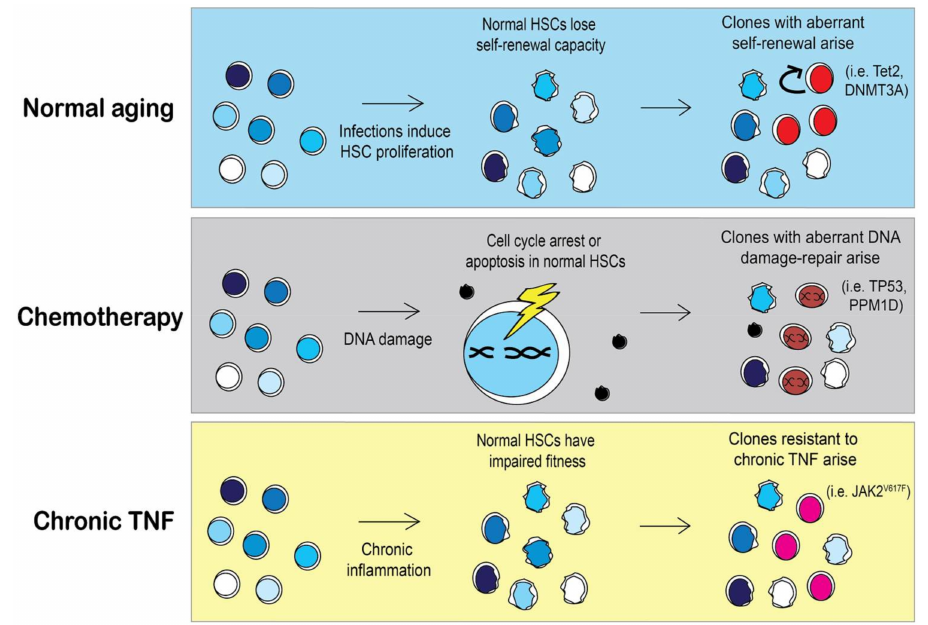
Figure 4. Selective pressures may shape clonal expansion of mutant HSCs. During aging HSCs lose their self-renewal capacity as the cells continuously replenish the blood system. As a result, HSCs with mutations that skew towards self-renewal, such as Tet2 or DNMT3A, will have a selective advantage over aged HSCs [84,86]. However, in a person that previously received chemotherapy, HSC clones with different mutations will arise. Chemotherapy induces DNA damage in HSCs and activates DNA damage repair pathways or apoptosis. The incidence of HSCs with mutations in DNA damage repair pathways such as TP53 or PPM1D is significantly higher in people with previous chemotherapy treatment [66]. Specific pressures may allow for the expansion of less common mutations such as JAK2 V617F . MPN patients with JAK2 V617F mutations have elevated TNF α , contributing to the chronic inflammatory environment. Under chronic inflammation, normal HSCs will become exhausted and lose their competitive fitness, allowing for the emergence of mutant HSCs that are resistant to TNF α